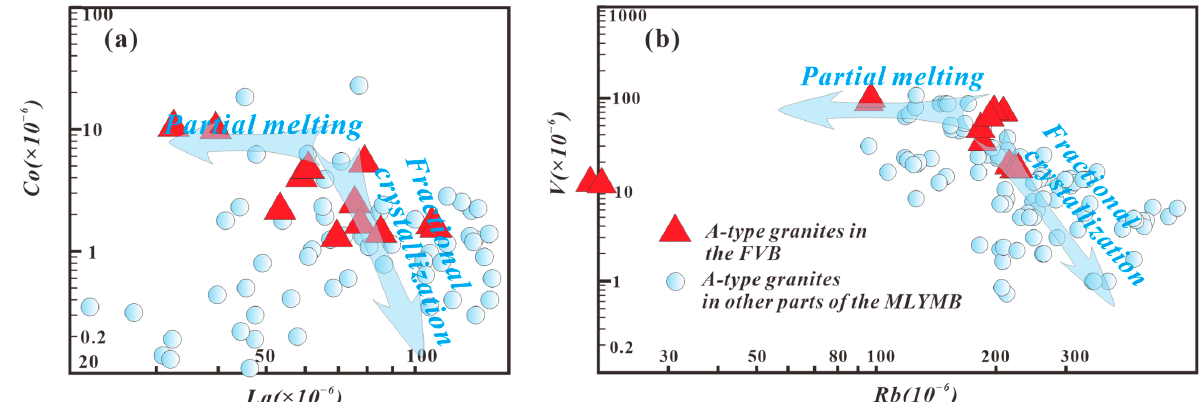
Figure 5. Log–log diagrams of compatible elements’ content vs. incompatible elements’ content of A-type granites in the FVB and other areas in the MLYMB (after [153]): ( a ) Co vs. La; ( b ) V vs. Rb. Data sources (see Supplement Table S1): A-type granites in the FVB are from [46,82,85,88,89]; other areas in the MLYMB are from [46,84,92–94,96,98,100,101,107,108]. Data sources of Figures 6–8 are the same as Figure 5.